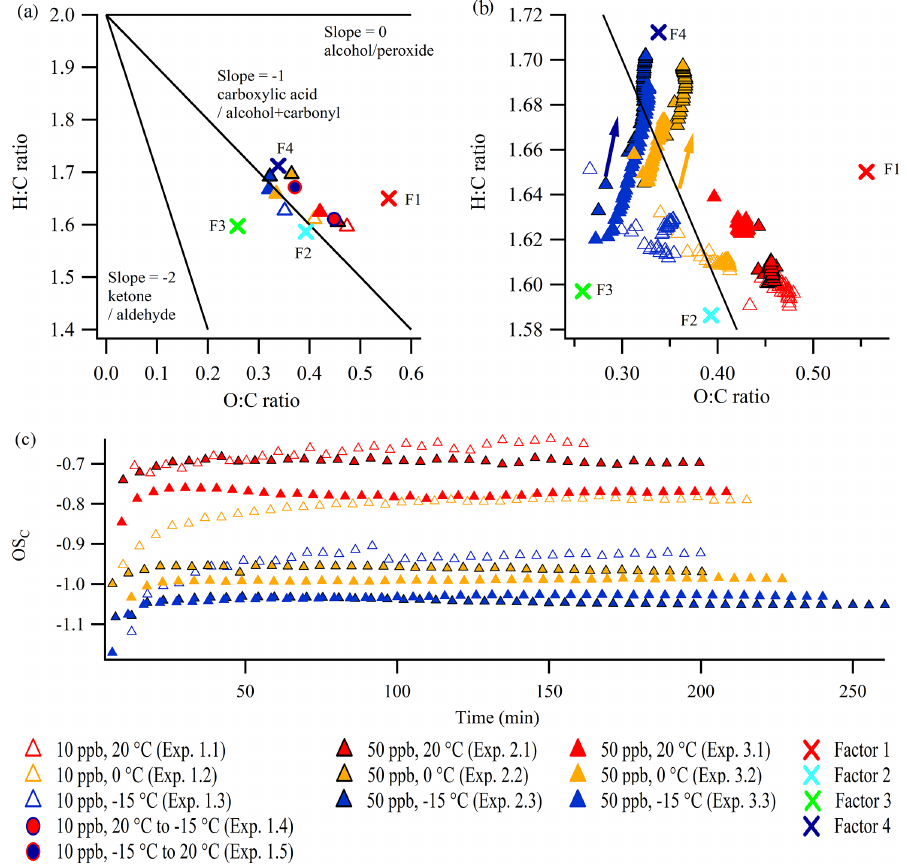
Figure 5. Van Krevelen plots (H : C ratio vs. O : C ratio) at (a) the SOA mass peak (five-data-point average) and in the expansion (b) during the constant temperature experiments in this work (arrows indicate the direction of time). (c) The OS C during the experiments. The lines in the Van Krevelen plots are based on Heald et al. (2010) and Ng et al. (2011). Note the different scales of the axes in panels (a) and (b) . The positions of the four factors obtained from the PMF analysis are indicated by crosses: F1 denotes Factor 1 (high temperature), F2 denotes Factor 2 (low concentration), F3 denotes Factor 3 (high concentration), and F4 denotes Factor 4 (low temperature). Panels (b) and (c) show every fifth data point. Standard errors are shown in Figs. S25 and